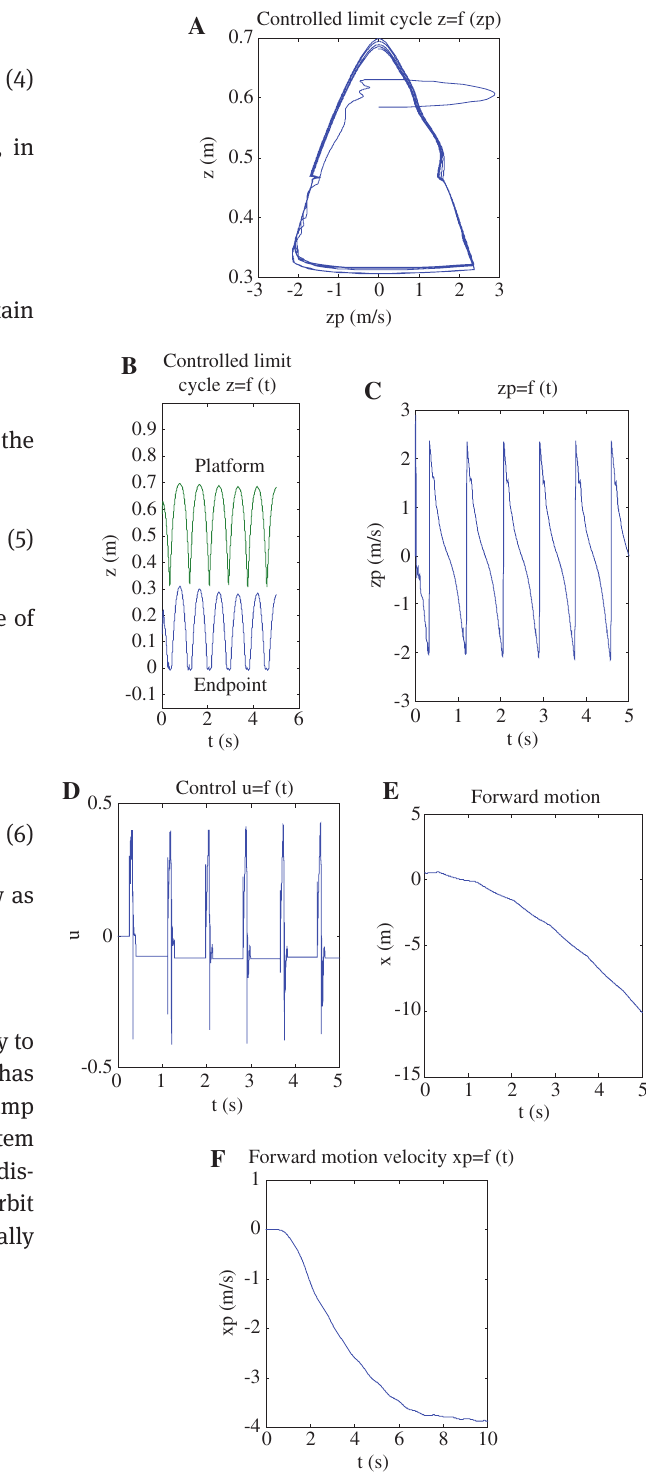
Figure 5: Experimental results. = 200; the simulation results. The control gains are K p = 1.5; Λ = 1. Figure 5A represents the limit controlled cycle K parameters errors. This error can be reduced by use of v = 0.6 m. The steady state error an integral action. The platform position, as well as the for a desired jump height z m leg endpoint position, is depicted in Figure 5B. Figure on the maximum height is due to stiffness and inertial